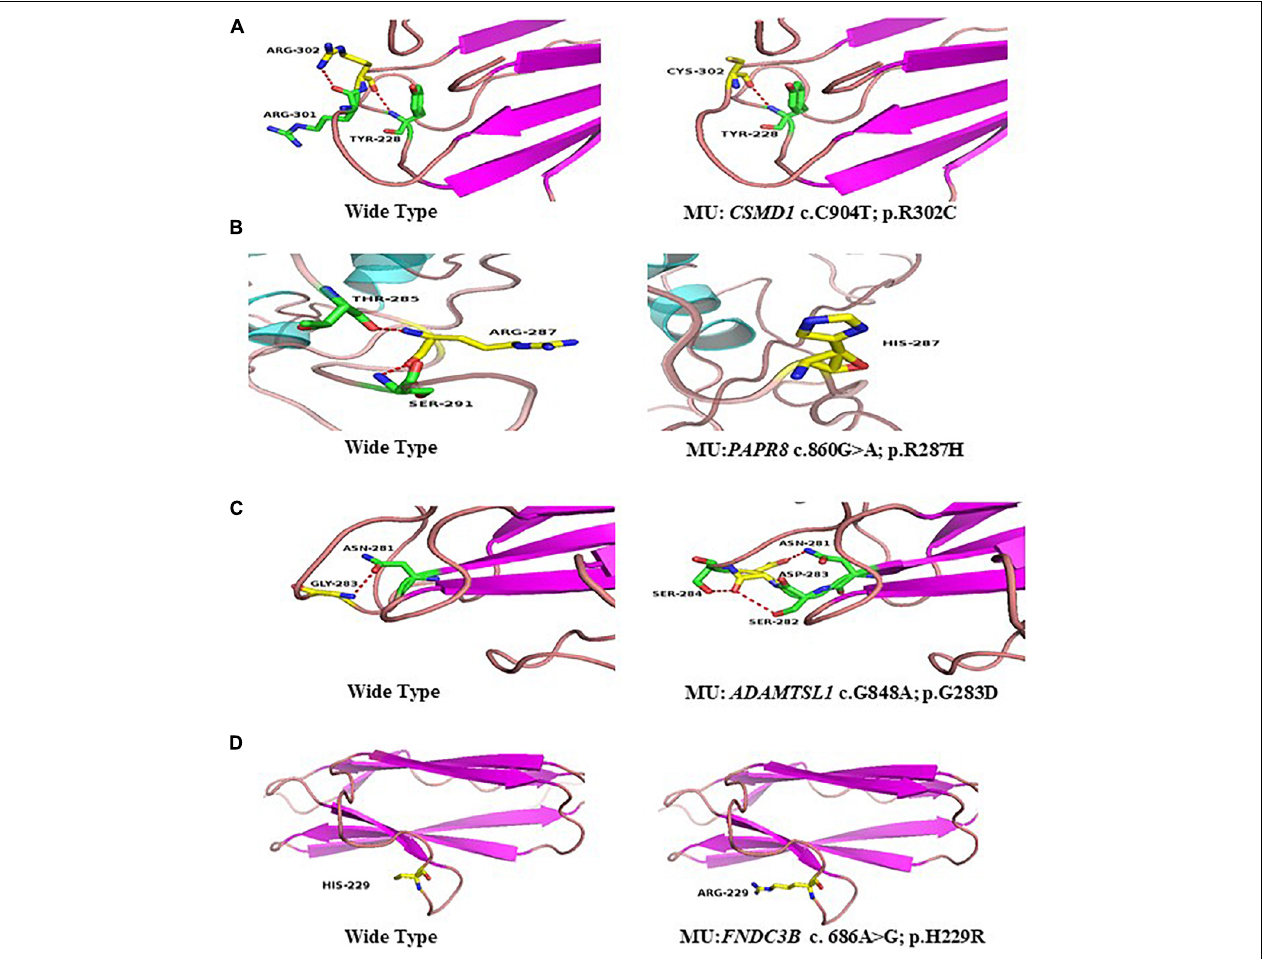
FIGURE 7 | Predicted three-dimensional (3D) structure of proteins. Predicted crystal structures of wild-type (left) and mutant (right) proteins. Yellow shows residue of wild-type and mutant; green represents residues interact with wild-type (left), and mutant residue (right) (A–D)